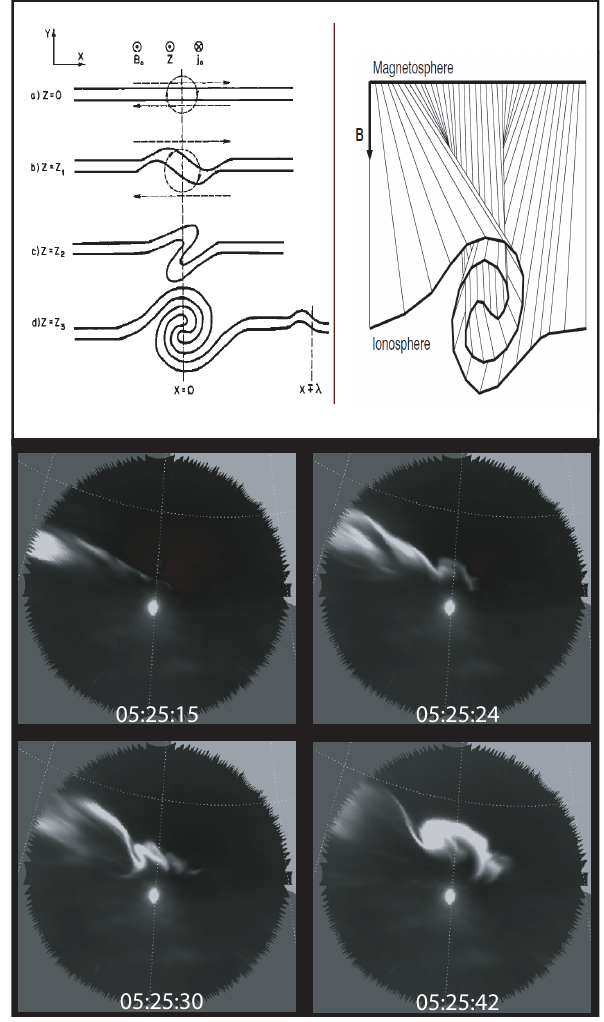
Fig. 12. Top: Illustration of field line deformation from the magne- tosphere to the ionosphere in association with auroral spirals. The left figure is from Hallinan (1976). The right figure is from Par- tamies (2004). Bottom: Selected ASI images showing different stages during the auroral spiral formation on 19 February